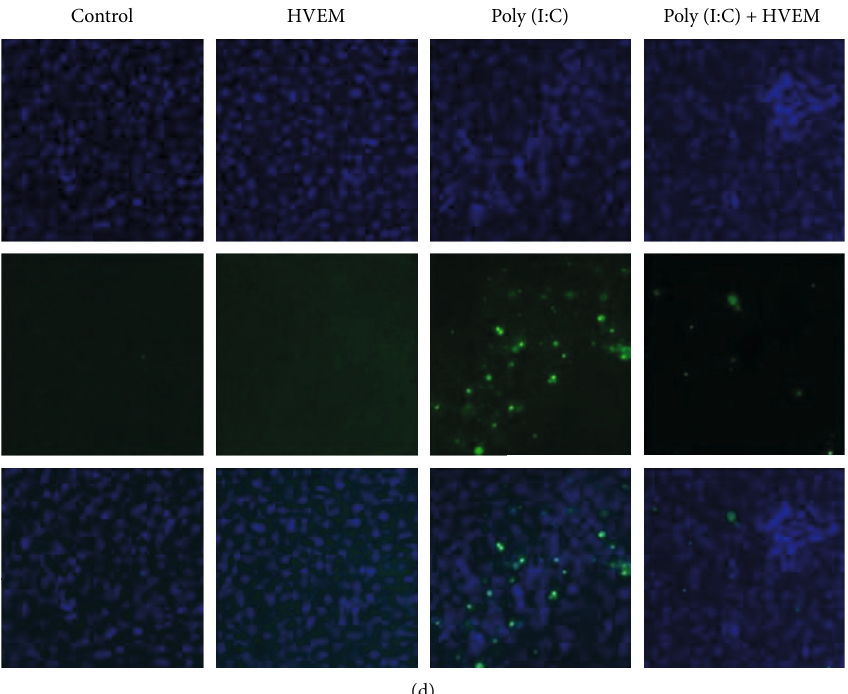
Figure 3: Blockade of LIGHT with recombinant HVEM-Fc fusion protein ameliorates liver injury induced with poly(I:C). (a) BALB/c mice were pretreated with recombinant HVEM-Fc protein (100 μ g/mouse) one hour before a lethal dose of poly(I:C) (2.5 μ g/mouse) and D-GalN (10 mg/mouse) injection ( n = 8 ) or poly(I:C) and D-GalN ( n = 8 ) only. The survival of mice was monitored. (b) BALB/c mice were pretreated with recombinant HVEM-Fc protein (100 μ g/mouse) one hour before a sublethal dose of poly(I:C) and D-GalN injection ( n = 8 ) or poly(I:C) and D-GalN ( n = 8 ) only. At 8, 16, and 24h time point, serum ALT levels were measured and data are shown as mean + SEM ; ∗∗ p < 0 : 01 , ∗∗∗ p < 0 : 001 . Mice were sacri fi ced at 24h and the liver tissues were fi xed and stained with H&E (size bar represents 50 μ m) (c) and TUNEL staining (size bar represents 20 μ m)